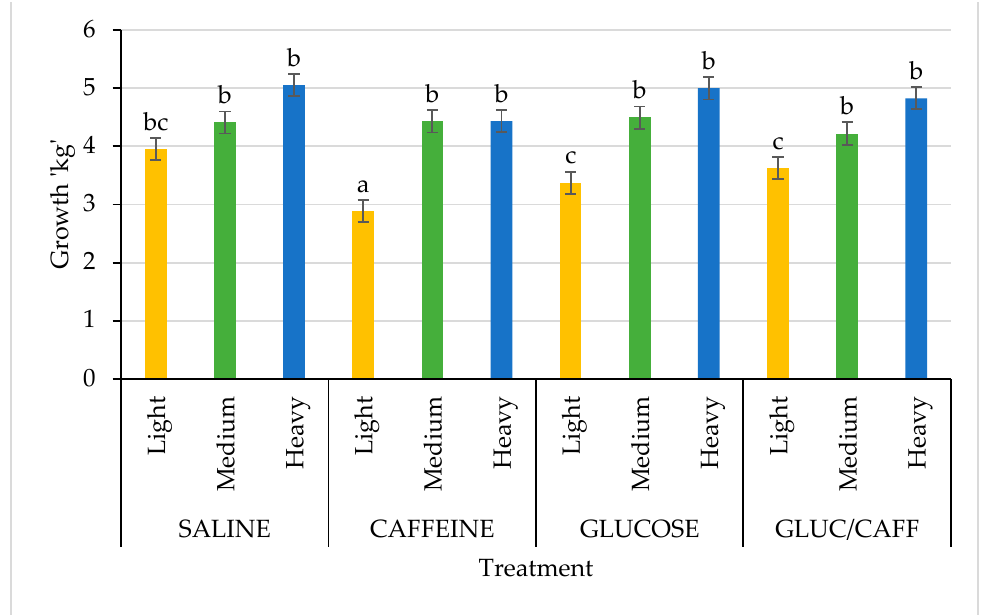
Figure 2. Comparison of growth for birth weight categories (light (yellow): < 0.9 kg, medium (green): 1–1.4 kg, heavy (blue): > 1.5 kg) from day 1 to day 18 of age between the four treatments: saline (SAL), caffeine (CAFF), glucose (GLUC), and caffeine plus glucose (CAFF-GLUC). Means with differing letters (abc) are significantly different ( p < 0.05). Data shown as mean ± SEM (error bars). Overall, treatment did not negatively or positively influence piglet pre-weaning mor- tality (Table 3). The majority of mortalities occurred in the first 3 days (8.1%), with the least number of mortalities occurring between day 3 and 18 (3.2%; Table 3).